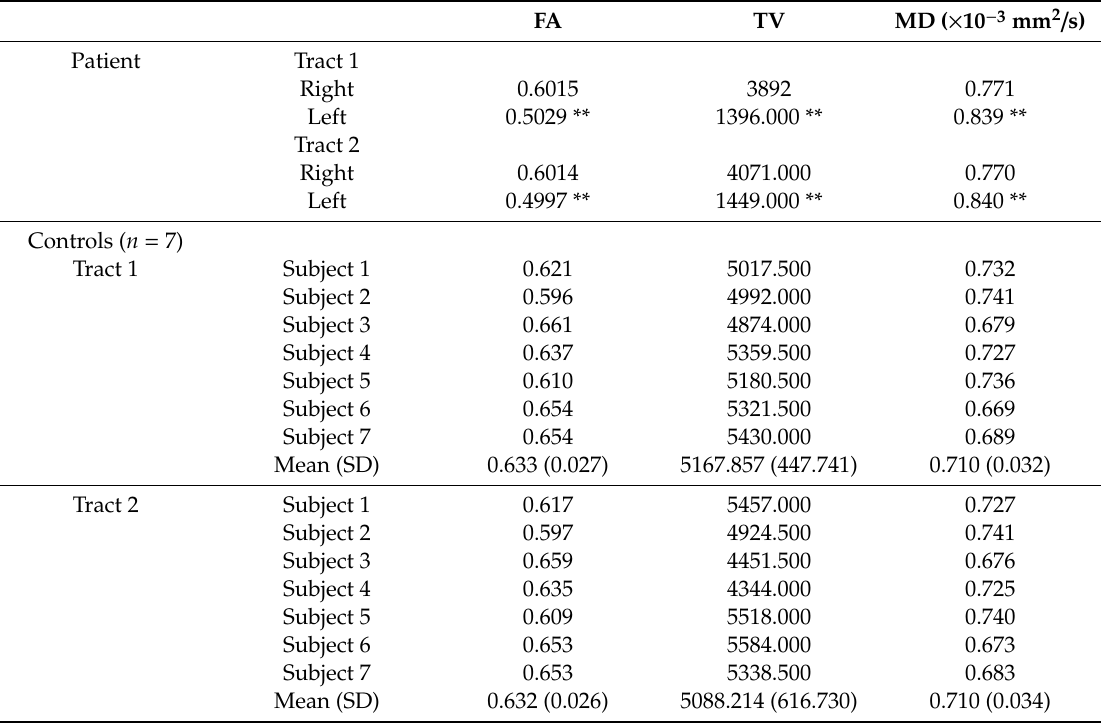
Table 1. DTT parameter of the corticospinal tracts of the patient and control